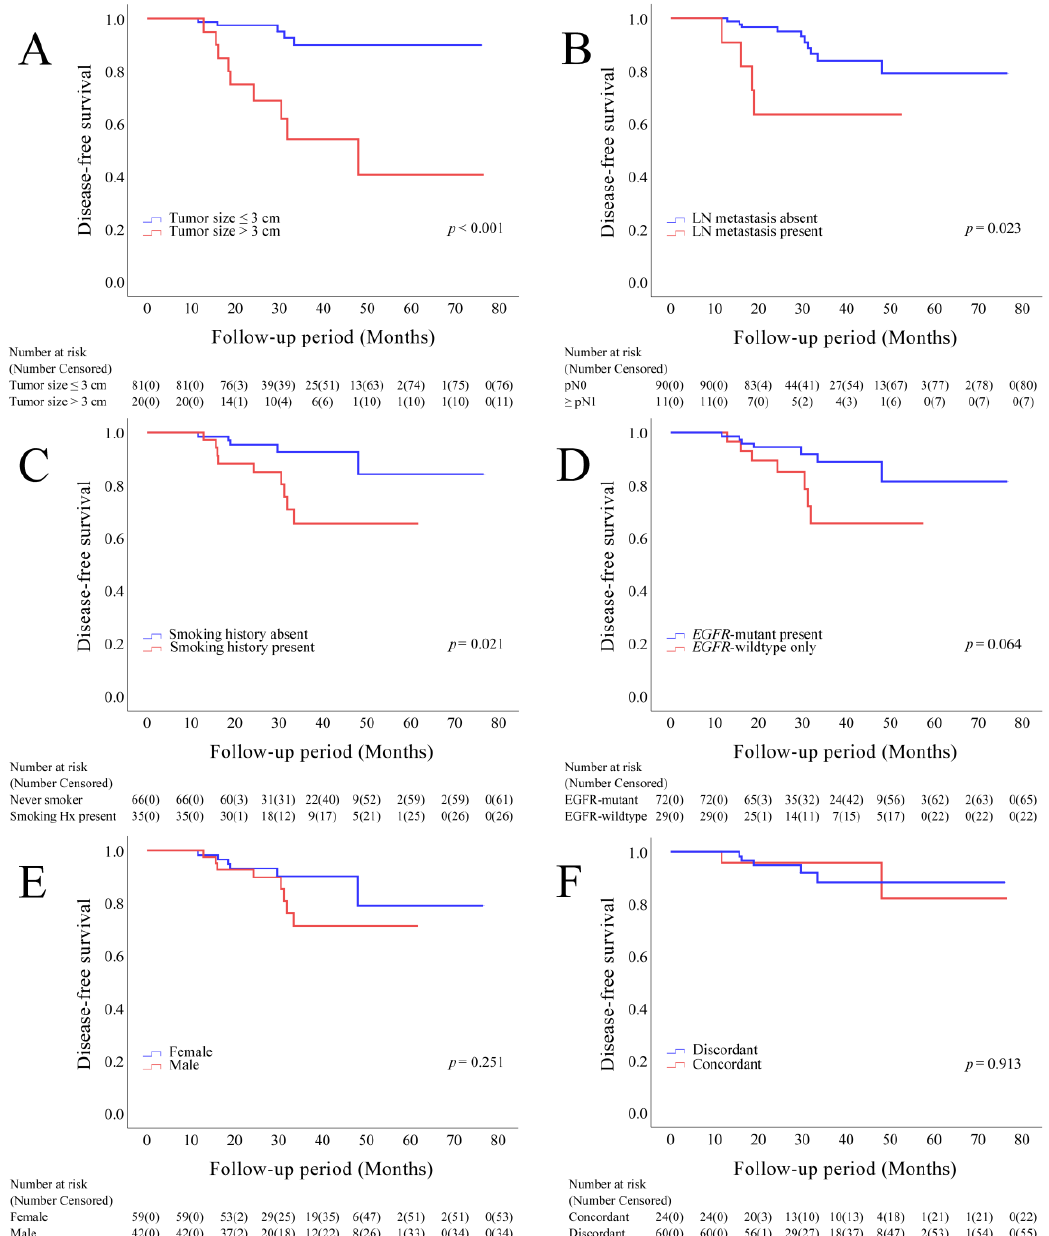
Figure 3. Kaplan–Meier survival curves depicting disease-free survival, stratified based on the size of the largest tumor ( A ), lymph node metastasis ( B ), smoking history ( C ), EGFR status ( D ), sex ( E ), and concordance of molecular alterations in individual tumors ( F